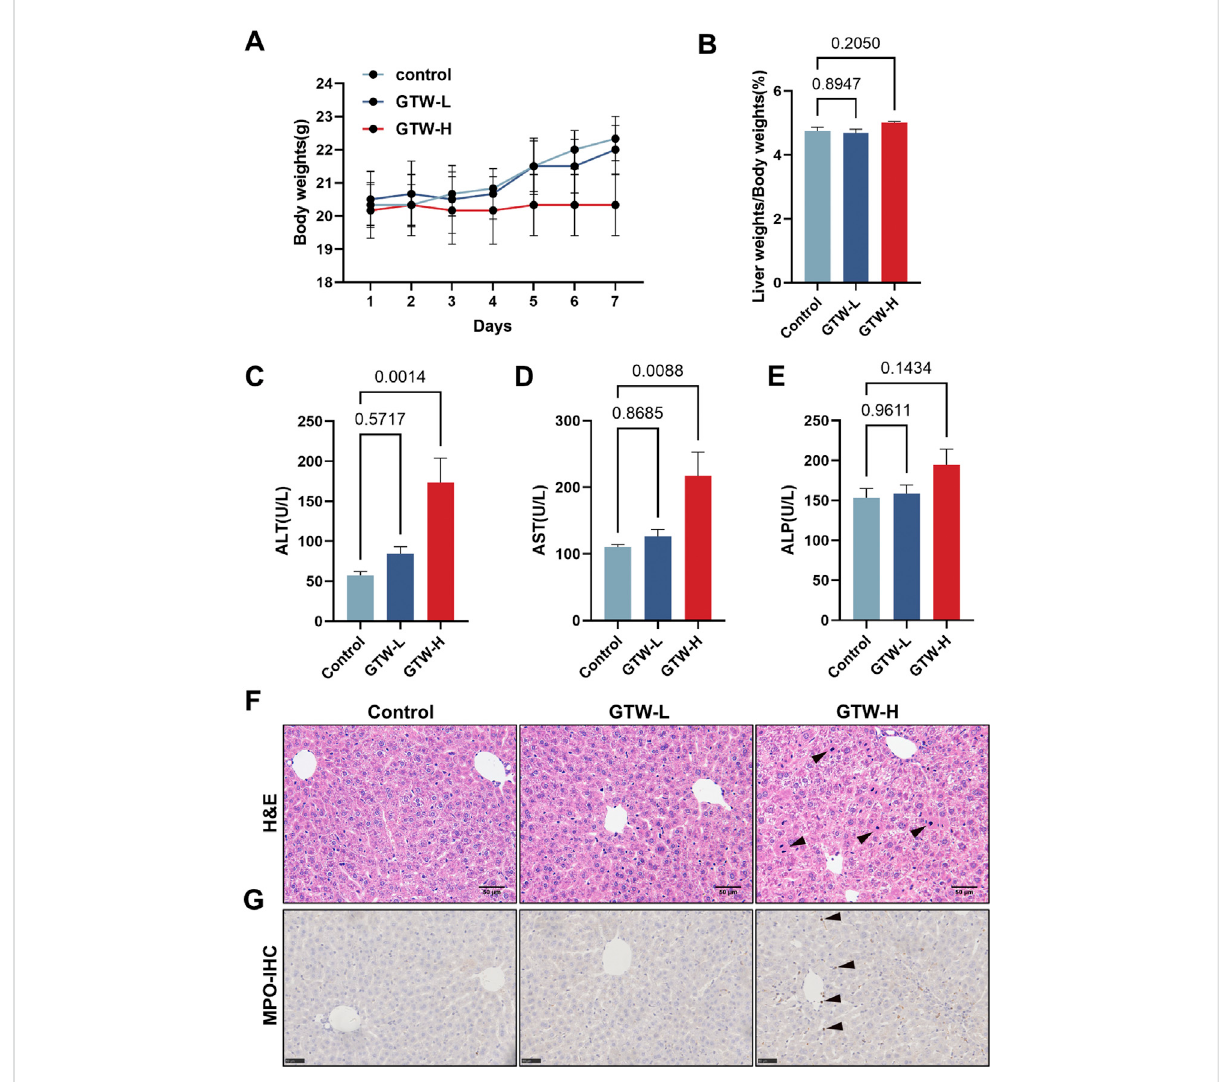
FIGURE 2 GTW administration caused liver injuryin mice. (A) Changes in body weights ( n = 6). (B) Liver tissue index calculated by tissue and body weights ( n =6). (C – E) Serumaminotransferaselevels,includingALT,AST,andALP( n =6). (F) RepresentativeH&Estainingimagesofliversections(scalebar= 50 μ m), and nuclear pyknosis was pointed with black arrows. (G) Representative immunohistochemical measurements of liver in each group (scale bar = 50 μ m). MPO positive areas were pointed with black arrows. Data are presented as mean ± SEM. p < 0.05 was considered statistically signi fi